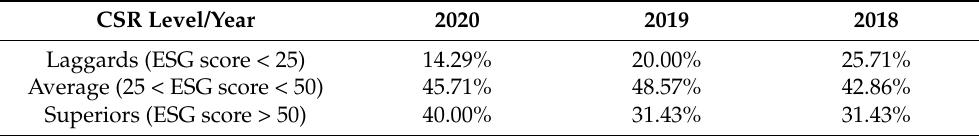
Table 3. Division of enterprises based on their CSR performance level.